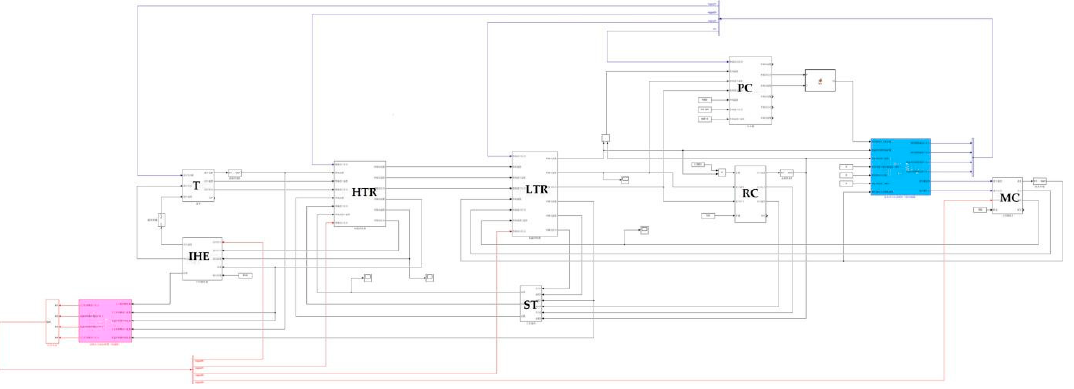
Figure 5. Simulink dynamic model diagram of SCO 2 recompression cycle. Table 1. Input parameters under design condition of recompression cycle model.